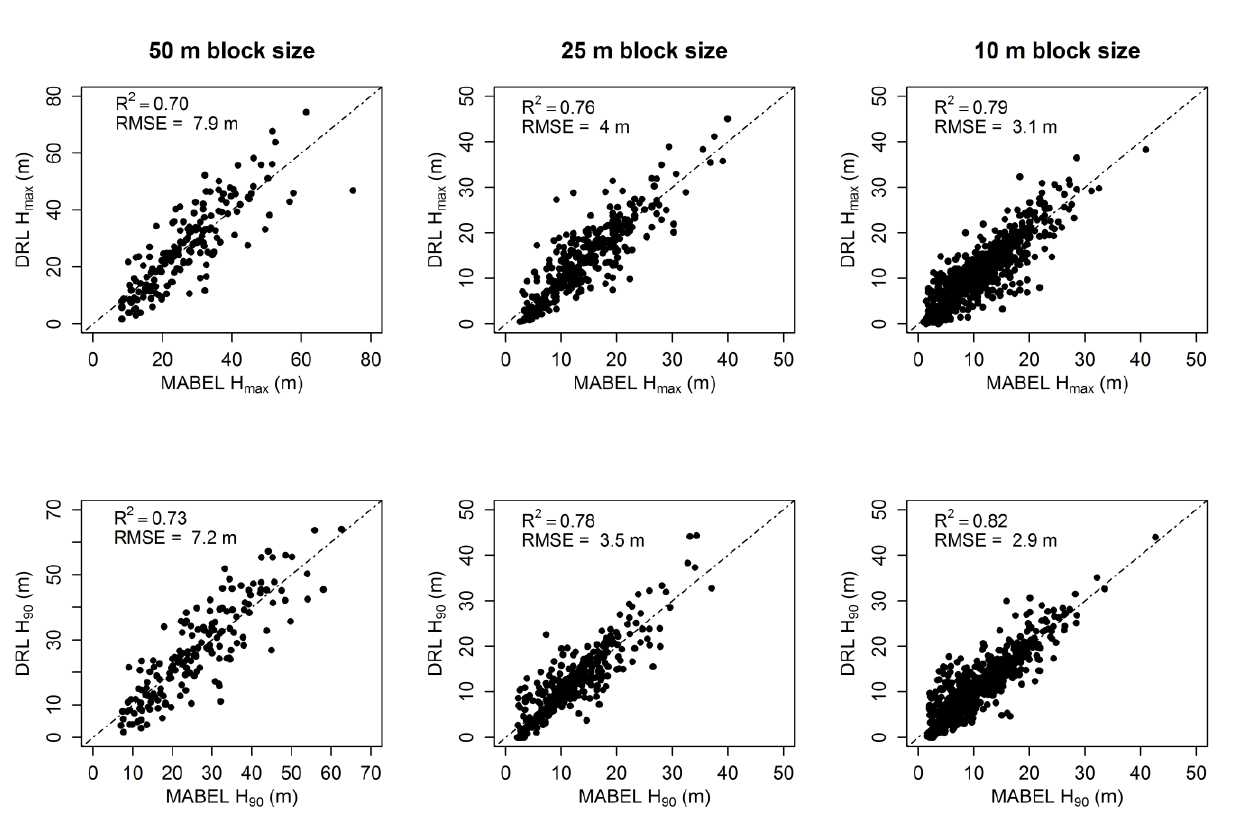
Figure 5. Validation plots for the height metrics at the different block